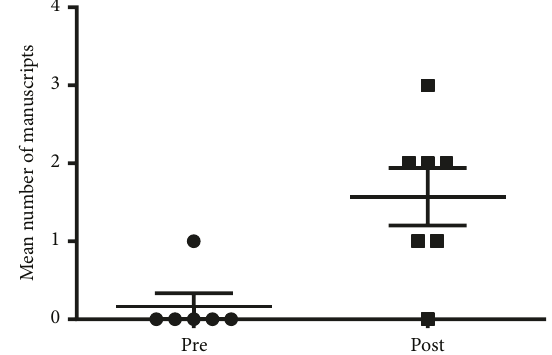
Figure 3: Mean number of manuscripts submitted by student- faculty dyads per six months prior to and subsequent to the development of the Rheumatology Interest